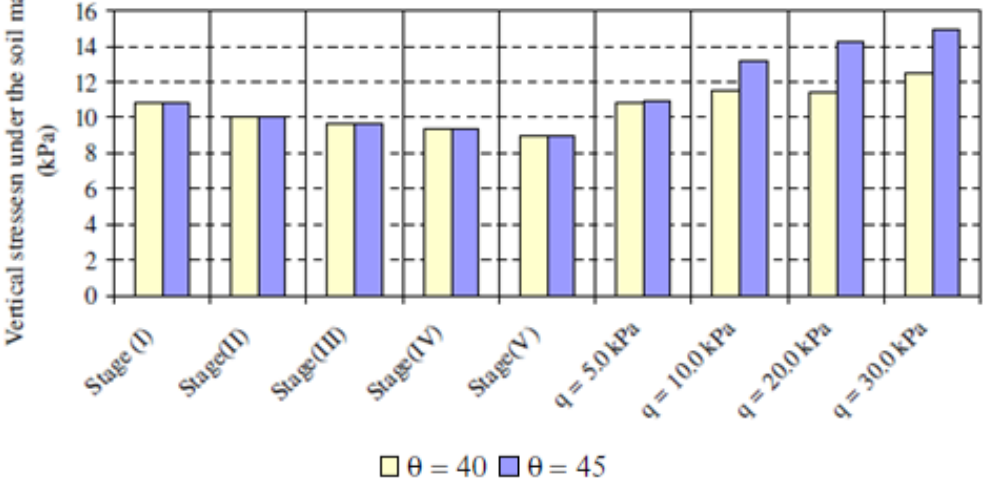
Figure 16. Influence of slope inclination on vertical stresses under the nailed soil mass.